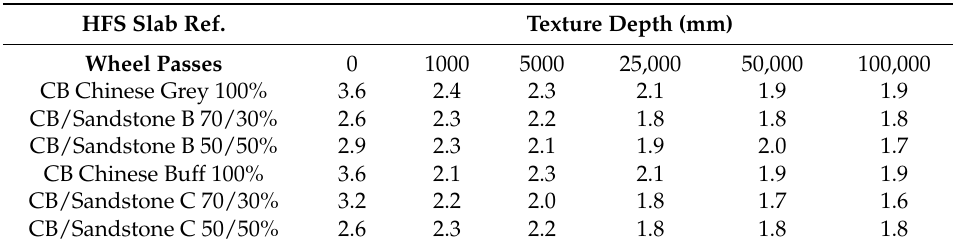
Table 5. Texture depth data (Ulster University data). HFS Slab